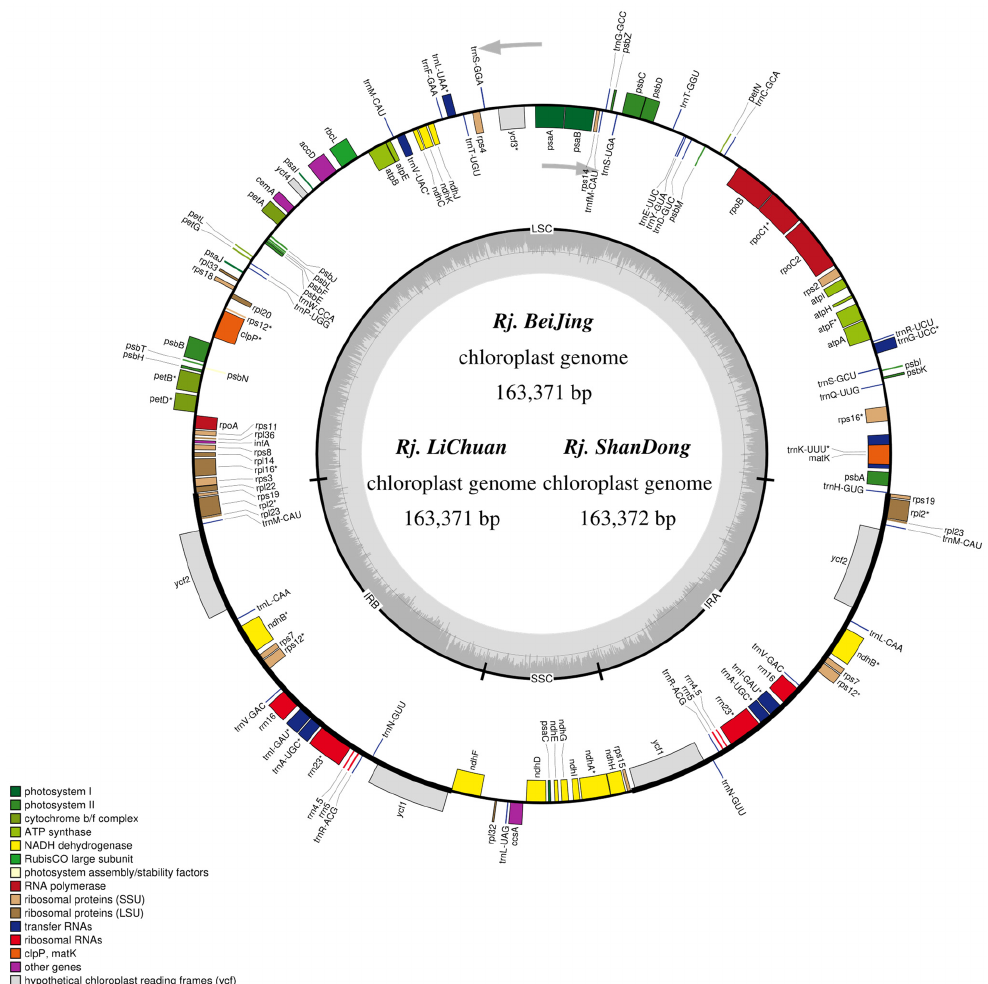
Figure 1. Gene map of the three R. japonica chloroplast genomes. Genes drawn inside the circle are transcribed clockwise, and genes outside are transcribed counter-clockwise. Different colors encode genes belonging to different functional groups. The area in darker gray and lighter gray in the inner circle corresponds to GC content and AT content, respectively. Table 1. Chloroplast genome features of the three R. japonica.